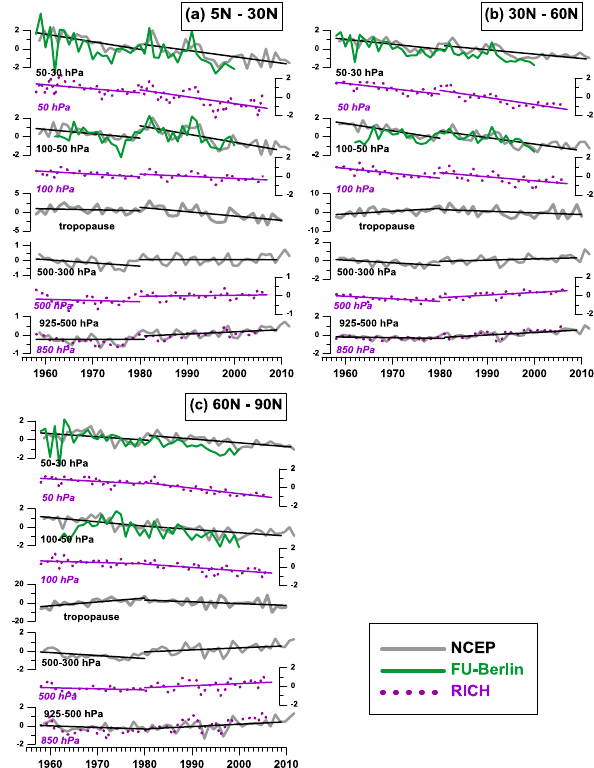
Figure 1. Layer mean temperature variations in Northern Hemi- Figure 1 sphere summer (JJA) at layers 925–500hPa, 500–300hPa, 100– 50hPa and 50–30hPa calculated from NCEP reanalysis and FU- Berlin data sets and filtered from natural variations for three latitu- dinal belts: (a) 5–30 ◦ N, (b) 30–60 ◦ N and (c) 60–90 ◦ N. The re- spective summer normalized time series of temperature from RICH data set at levels 850, 500, 50 and 30hPa are also illustrated as well as the NCEP tropopause pressure. The trend lines before and after 1979 are superimposed. Grey lines denote NCEP reanalysis vari- ations. Green lines denote variations as depicted in the FU-Berlin analysis, while purple dotted lines denote the RICH data tempera- ture. The units of vertical axes are in ◦ C except for the tropopause which is in